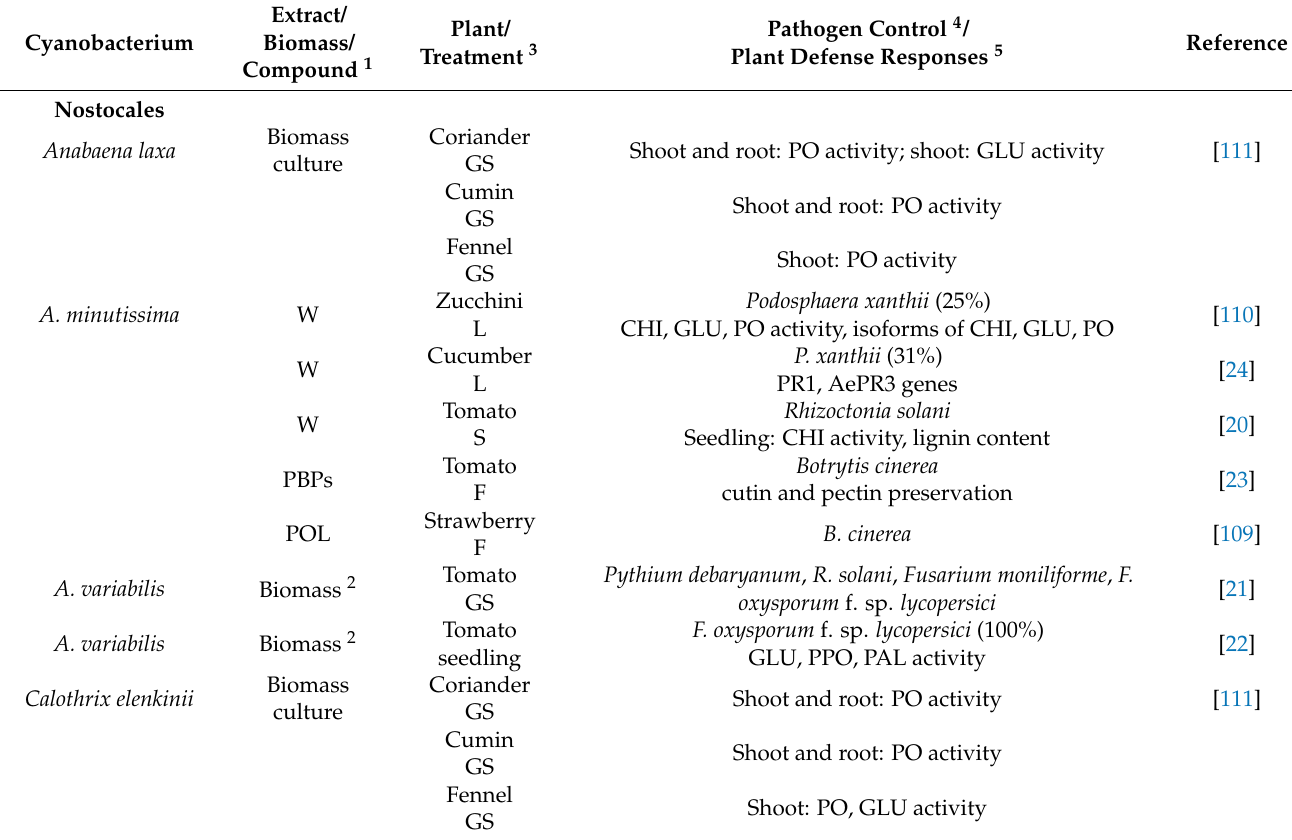
Figure 5. Foliar and soil-borne pathogens controlled by cyanobacteria application and plant de- fense responses in shoot and root induced by the cyanobacteria reported in this review. CAMC, carboxymethyl cellulose; CHI, chitinases; CHITO, chitosanase; GLU, β -1,3-glucanases; LOX, 13-lipoxygenase 2; PAL, phenylalanine ammonia lyase; PEP, phosphoenolpyruvate carboxylase; PO, peroxidases; PPO, polyphenol oxidases; PR, pathogenesis related proteins; WRKY, family of transcription factors. Table 2. Pathogen control and plant defence induction by cyanobacterial extracts and their single compounds applied on several plant species with different kind of